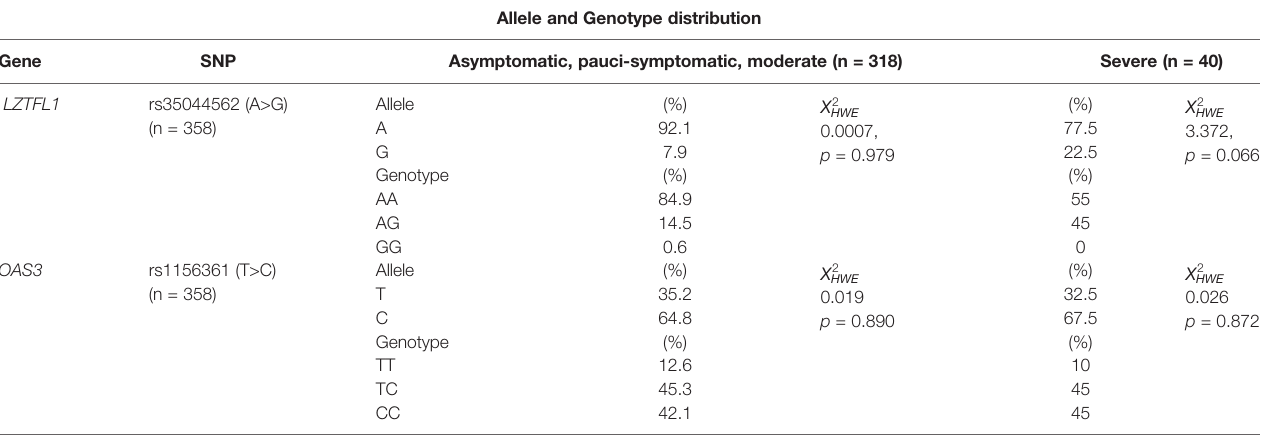
TABLE 2 | Allele and Genotype distribution of rs35044562 and rs1156361 in SARS-CoV-2 patients. Allele and Genotype distribution